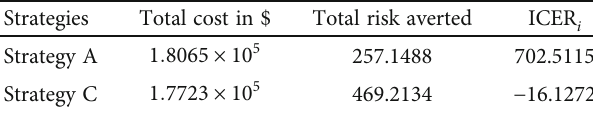
Table 3: ICER in increasing order of total risks averted. Table 2: ICER in increasing order of total risks averted.